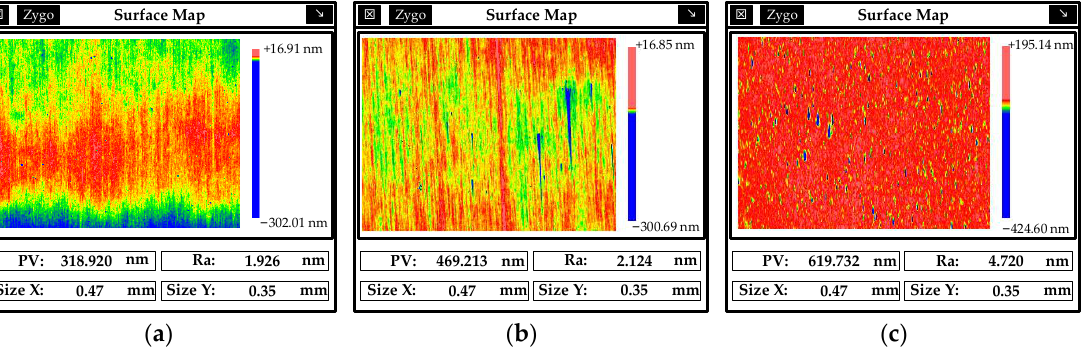
Figure 10. Surface roughness of modified layer after MRF processing with different abrasive particles. ( a ) Polished roughness with silica, ( b ) polished roughness with alumina, ( c ) polished roughness with diamond.